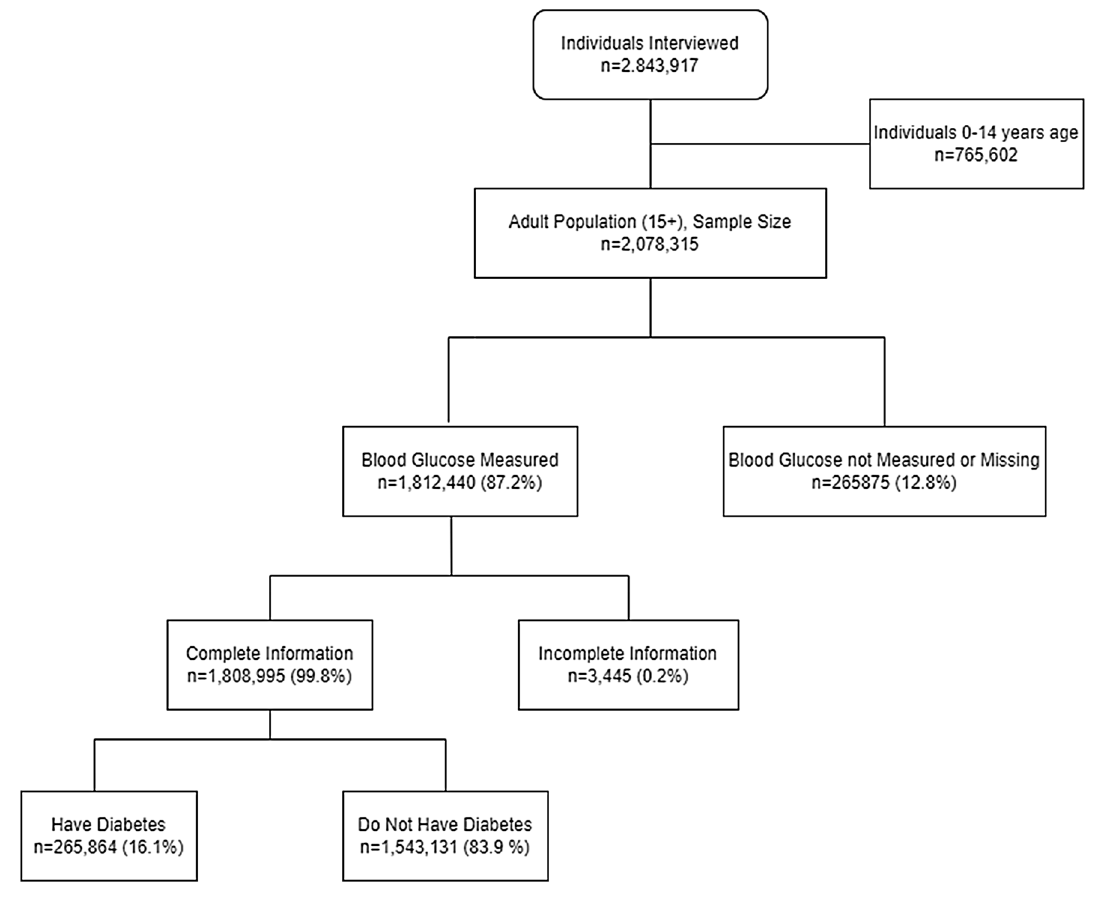
Figure 1. Flowchart of participant